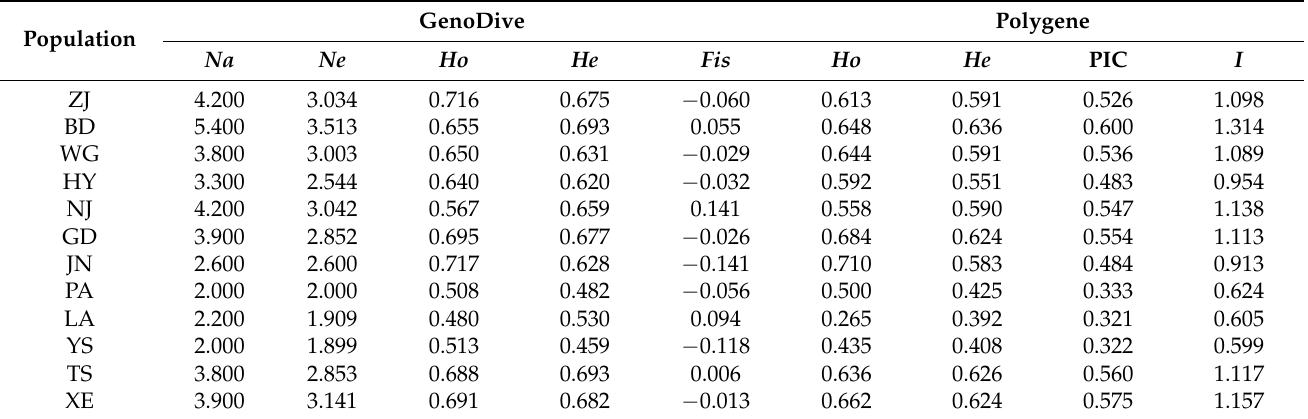
Table 6. Genetic diversity within C. macrophyllum populations at 10 SSR